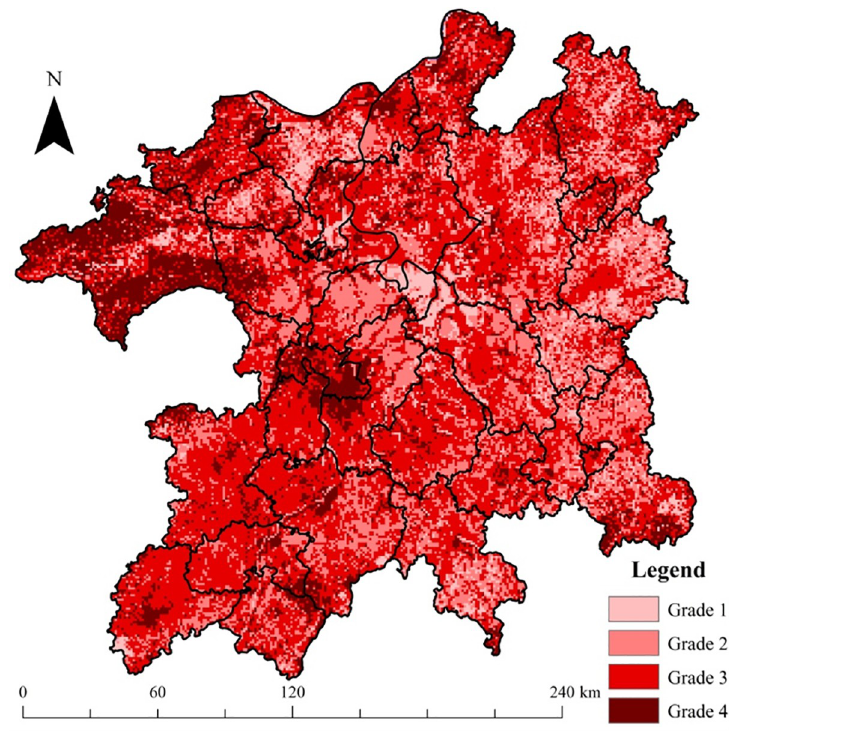
Fig 8. Grades of integrated eco-environmental vulnerability in the